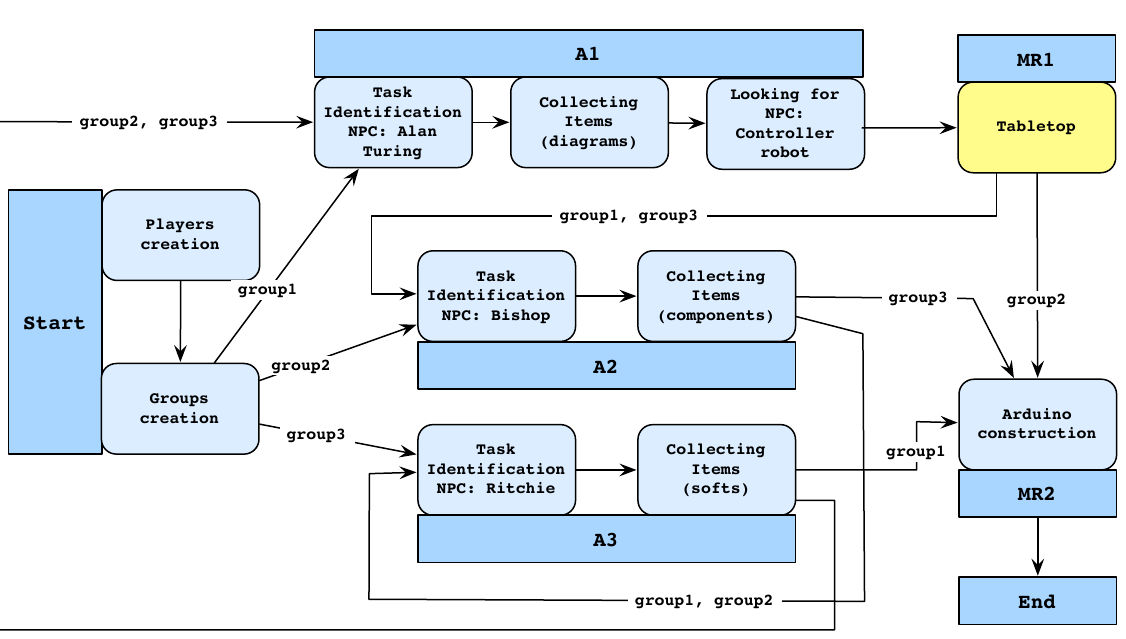
Figure 5. Non formal scheme representing the multiple